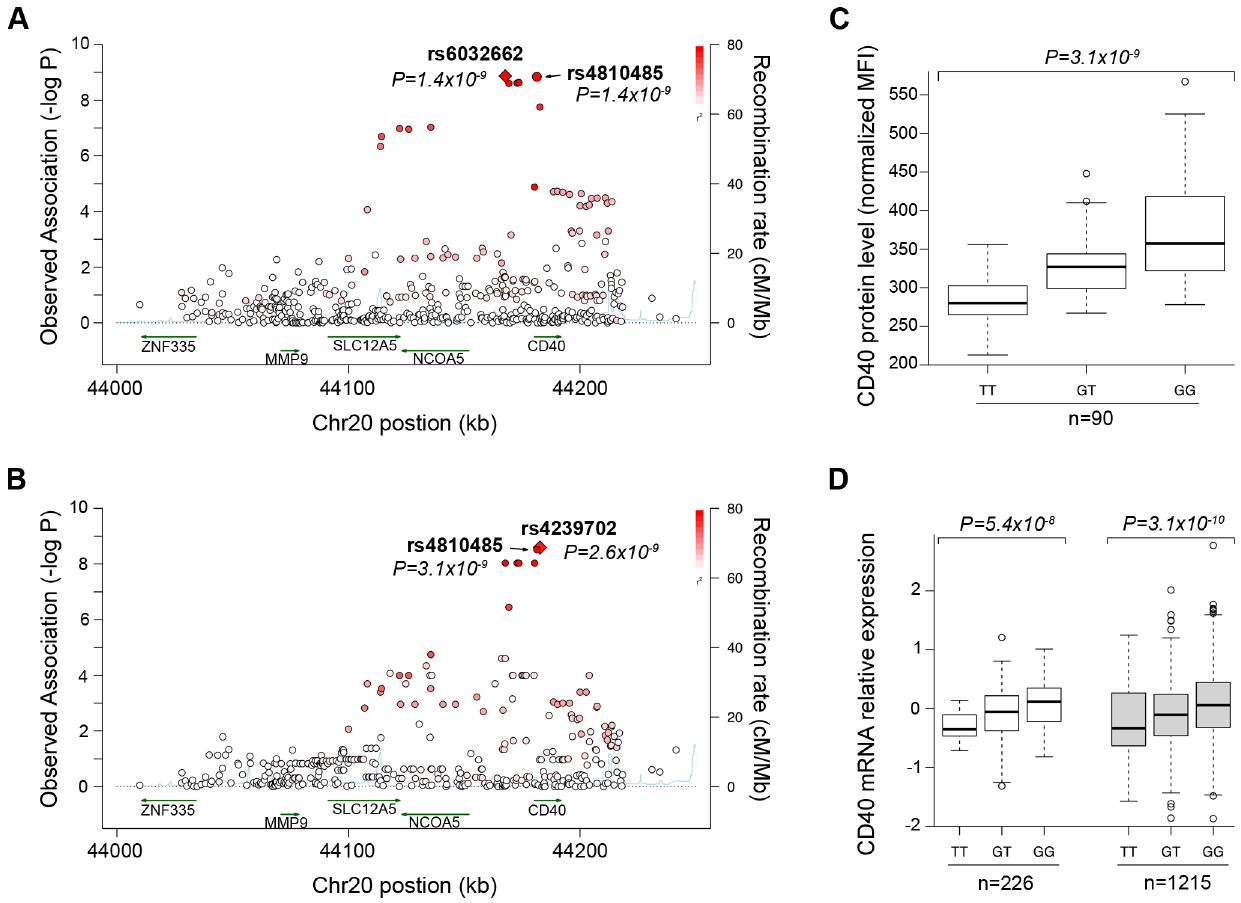
Figure 1. Genetic data on risk of RA and CD40 protein levels. (A) The regional association plot from analysis of Immunochip (iChip) data in 7,222 CCP + cases and 15,870 controls. Gene location is shown along the bottom of the graph, with observed –log(P) value along the left Y-axis and recombination rate along the right Y-axis. Each SNP is plotted is a circle, with color scheme (red to white) in reference to the extent of linkage disequilibrium with the index SNP, rs4810485 (labeled as a diamond). (B) The regional association plot from analysis of iChip data and CD40 protein levels in 90 healthy control individuals. (C) A box-whisker’s plot of SNP (rs4810485) and CD40 protein levels in B cells from healthy control individuals, where T=non-risk allele and G=risk allele. (D) A box-whisker’s plot of SNP (rs4810485) and CD40 mRNA levels in PBMC’s from two separate collections (total of 1,441 healthy control individuals); T=non-risk allele and G=risk allele.